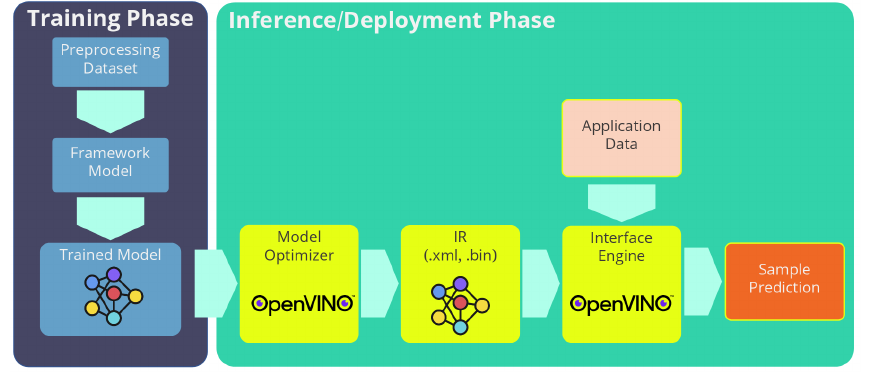
Figure 1. OpenVino structure.